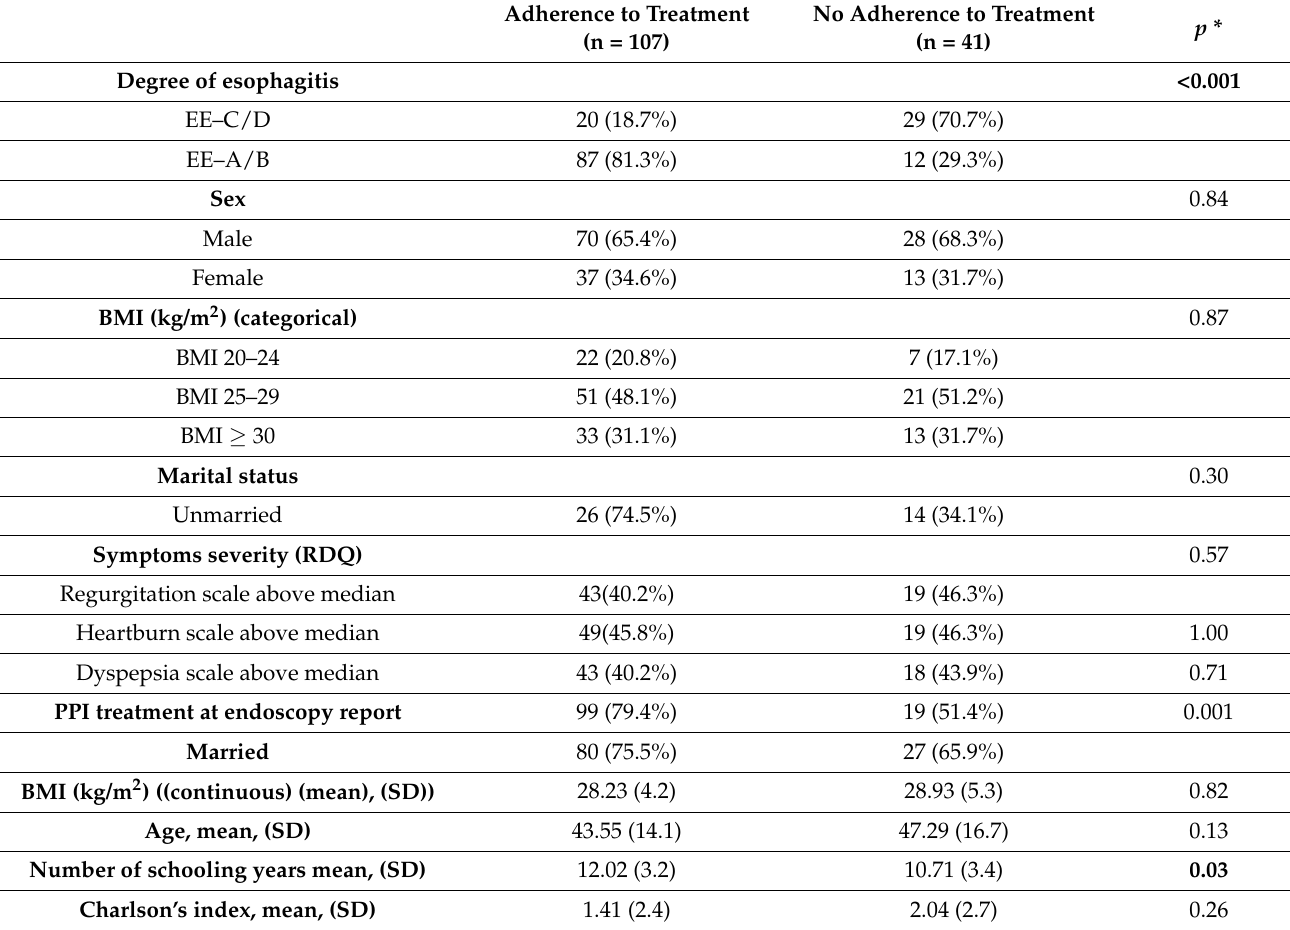
Table 3. Bivariate analysis of associations of demographic and clinical factors with adherence. Adherence to